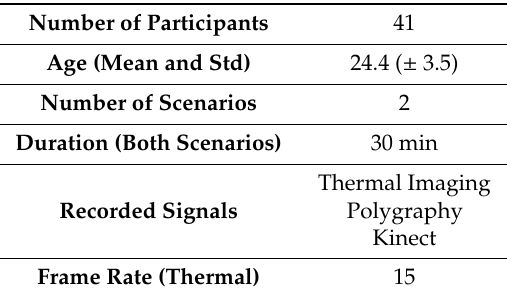
Table 1. Overview of the THEPHY